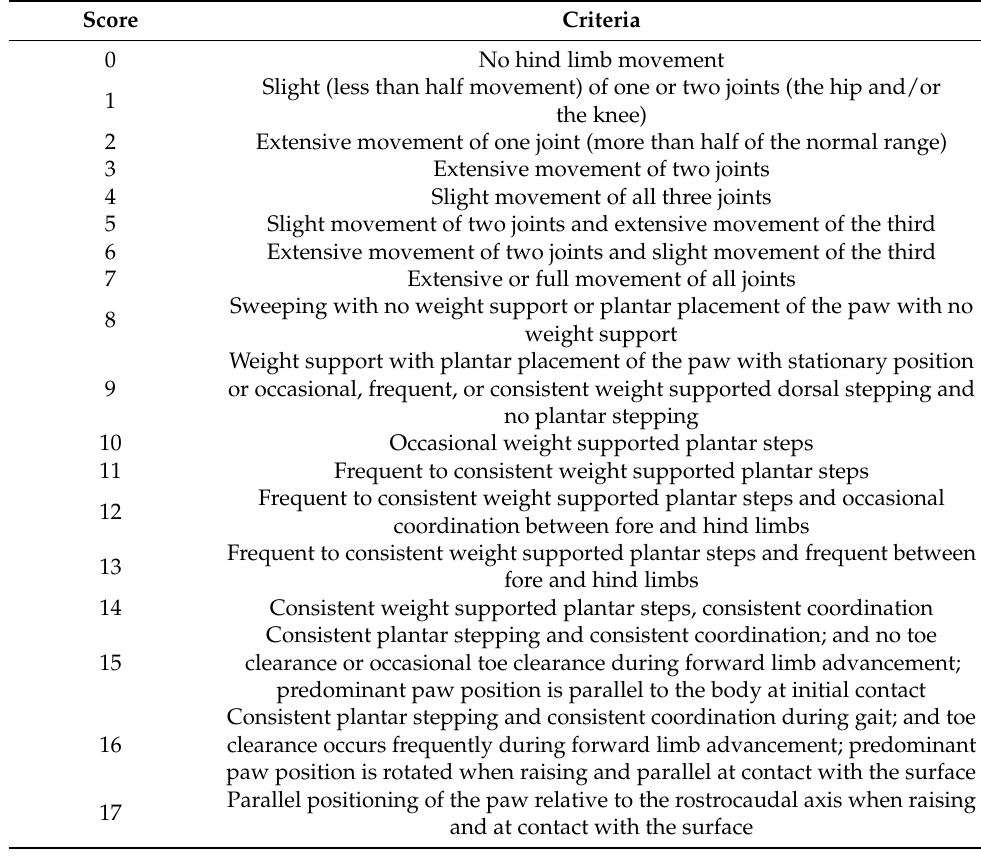
Table A1. Scoring for the BBB rating scale in rats after unilateral